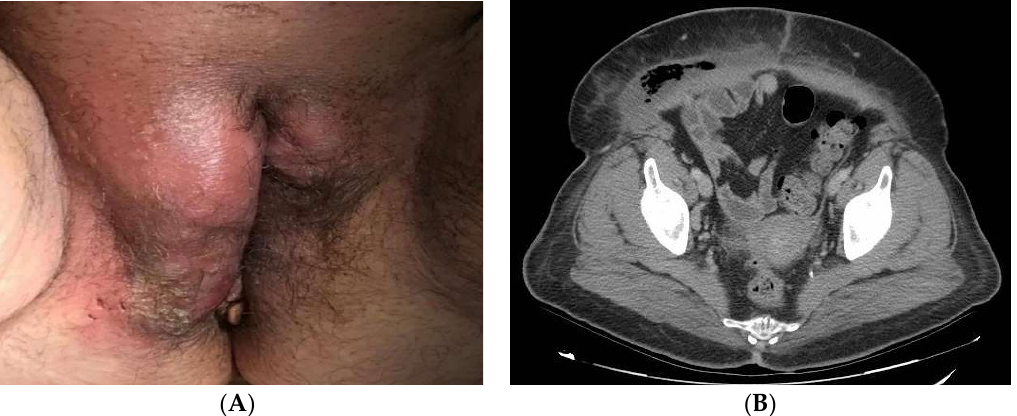
Figure 1. ( A ): Perineal abscess with induration of surrounding tissue. The most common onset site of FG is the labia majora. ( B ): CT of the abdomen and pelvis showing areas with gas revealing necrotic tissue from gangrene.